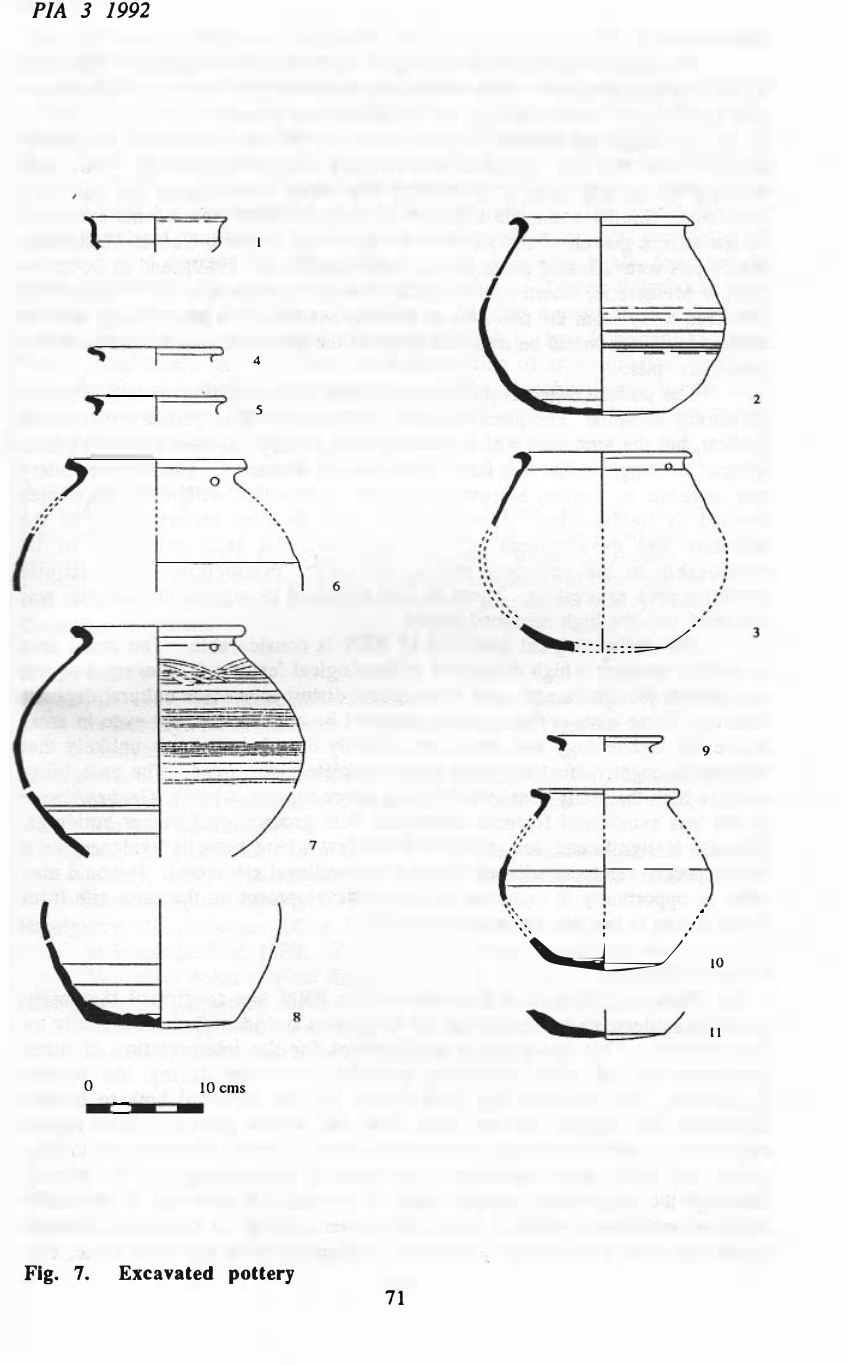
Fig. 7. Excavated